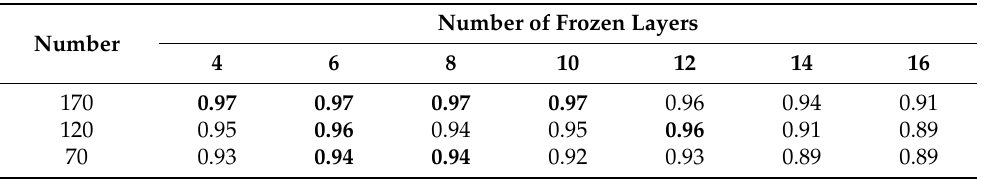
Table 5. The accuracy of the proposed OplusVNet with different frozen layer networks on different number of image training sets.